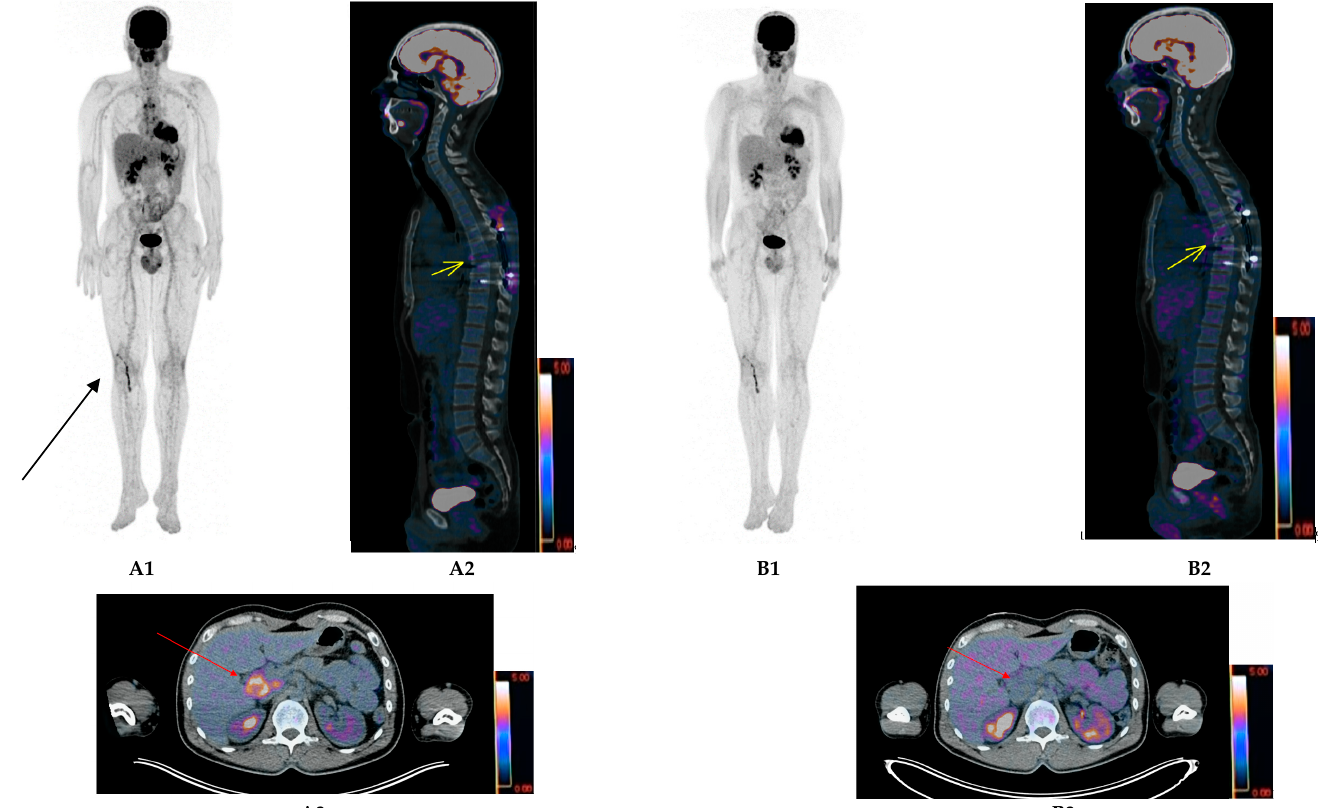
Figure 2. Thirty-nine-year-old patient with a IgAk MM revealed by a thoracic spinal cord compression. FDG-PET / CT images performed at diagnosis ( A1 : Maximum intensity projection (MIP) images) show a T7 vertebral body destruction with corresponding increased uptake in the sagittal fused slice (Yellow arrow A2 ) and a highly metabolically active liver hilary lymph node (Red arrow, A3 axial fused slice) suspect of extra-medullary disease (EMD). Of note, a recent right knee trans-arthroscopic reconstruction of the anterior cruciate ligament (ACL) by the Kenneth-Jones technique explaining the corresponding uptake (Black arrow in A1 image). FDG-PET / CT images performed after autologous stem cell transplantation (before maintenance therapy) show complete metabolic response ( B1 ) with no significant residual uptake ( < mediastinum blood pool, Deauville 2) of T7 vertebral body in sagittal fused slice (Yellow arrow, B2 ) and liver hilary lymph node in axial fused slice (Red arrow, B3 ).